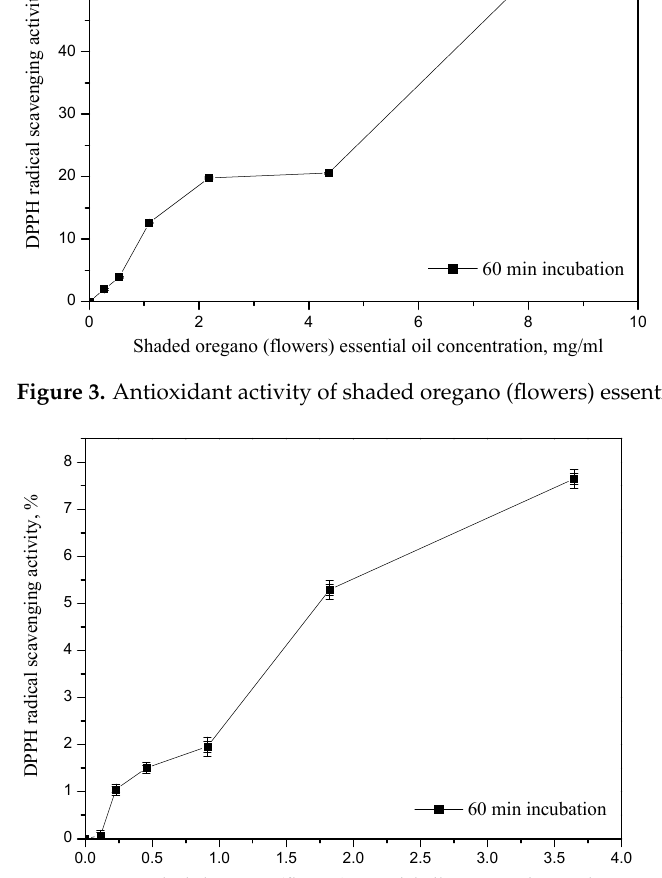
Figure 4. Antioxidant activity of nonshaded oregano (flowers) essential oil.